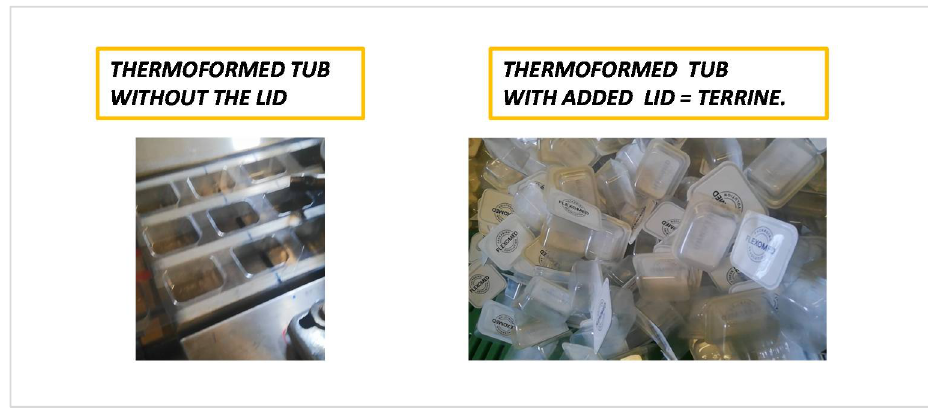
Figure 3. Example of terrine obtained in the thermoforming multi-stage machine studied. Standard operation requires the constant coordination of all sub-processes since a fail- ure in one of them means production stoppage. There is a master linear axis (see Figure 1) in the lower part of the machine that runs from the thermal conditioner of the polymer for the thermoformer container to the cutter for finished tubs, which permits coordinated movements with cams in synchronised positions to ensure the process is controlled at a constant